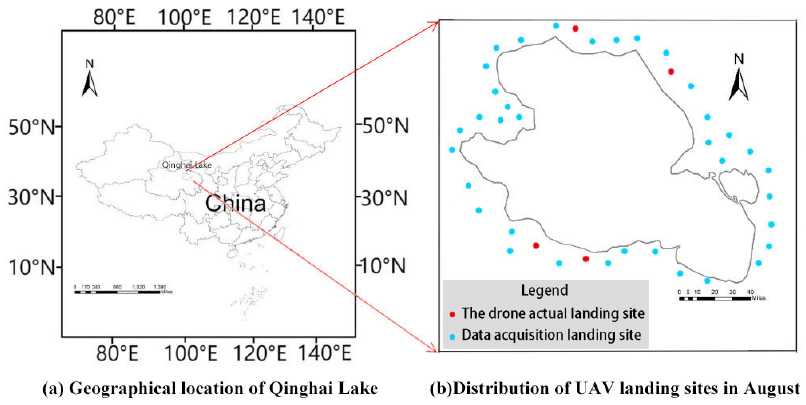
Figure 4. Research area: ( a ) geographical location of Qinghai Lake; ( b ) distribution of UAV landing sites in August.